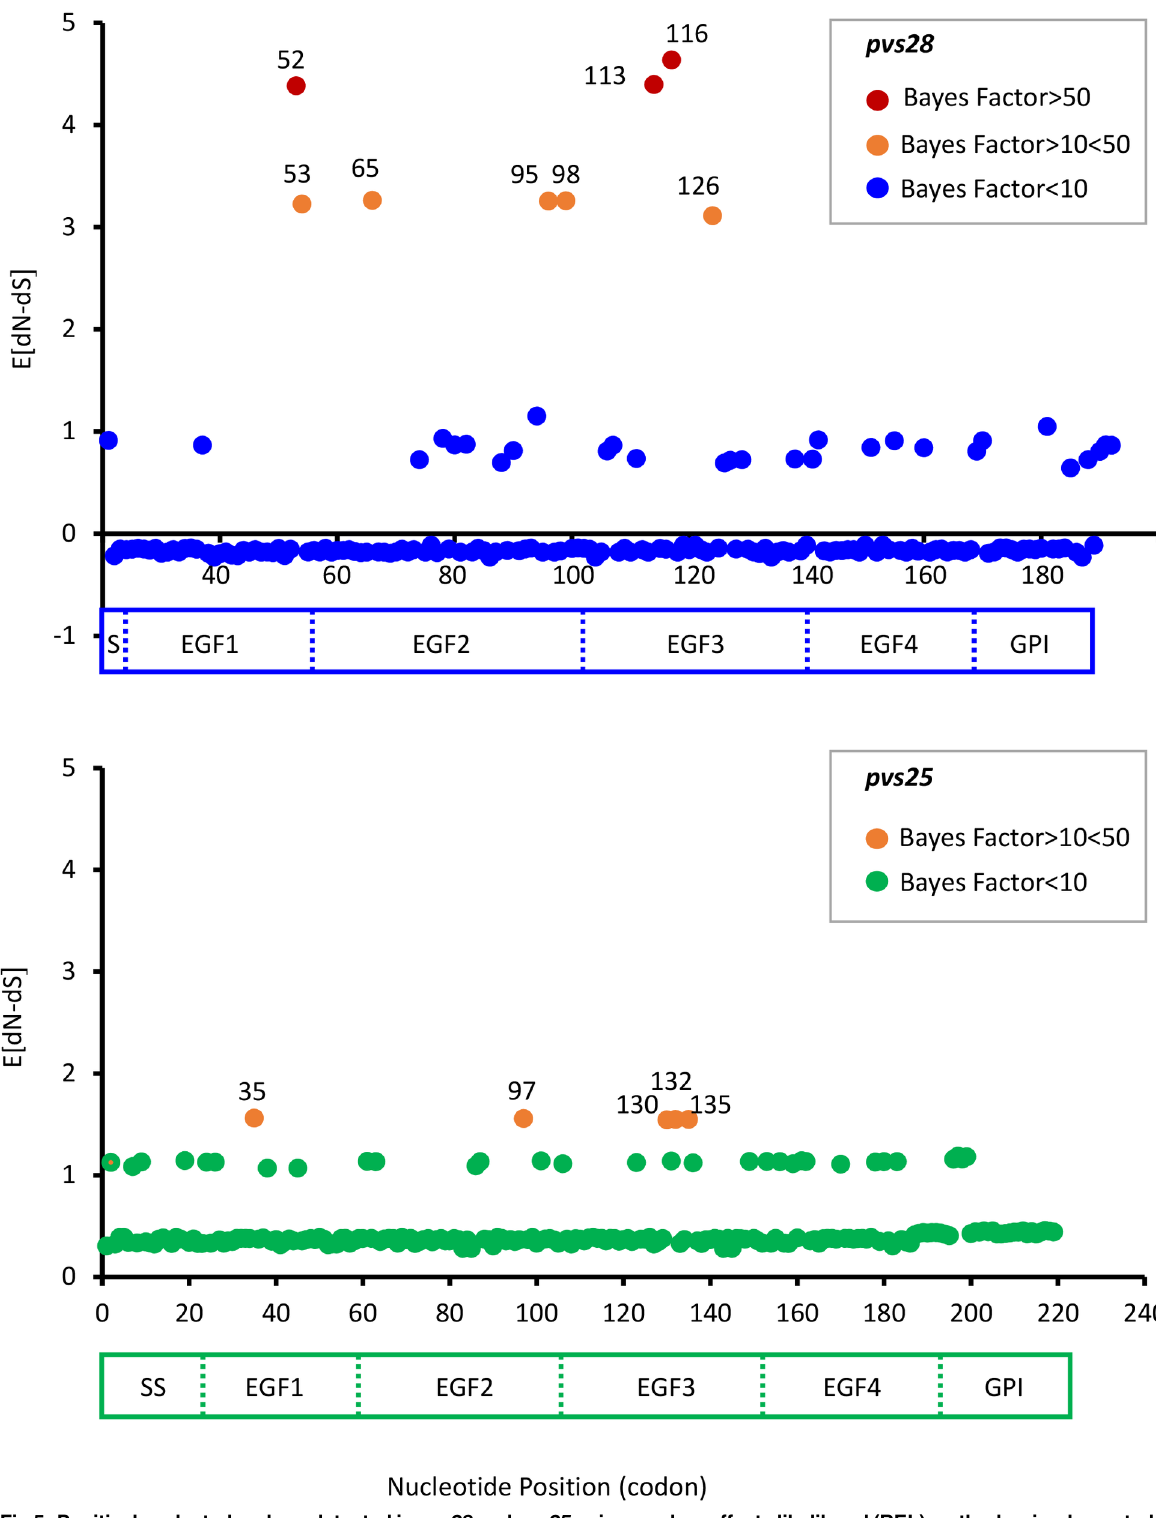
Fig 5. Positively selected codons detected in pvs28 and pvs25 using random effects likelihood (REL) method as implemented in HyPhy. The estimated dN-dS (E[dN-dS]) per codon across the pvs28 and pvs25 genes are depicted against their position using Salvador I as a reference (see S1 and S2 Tables). Schematic diagrams of Pvs28 and Pvs25 indicate their EGF domains. Pvs28